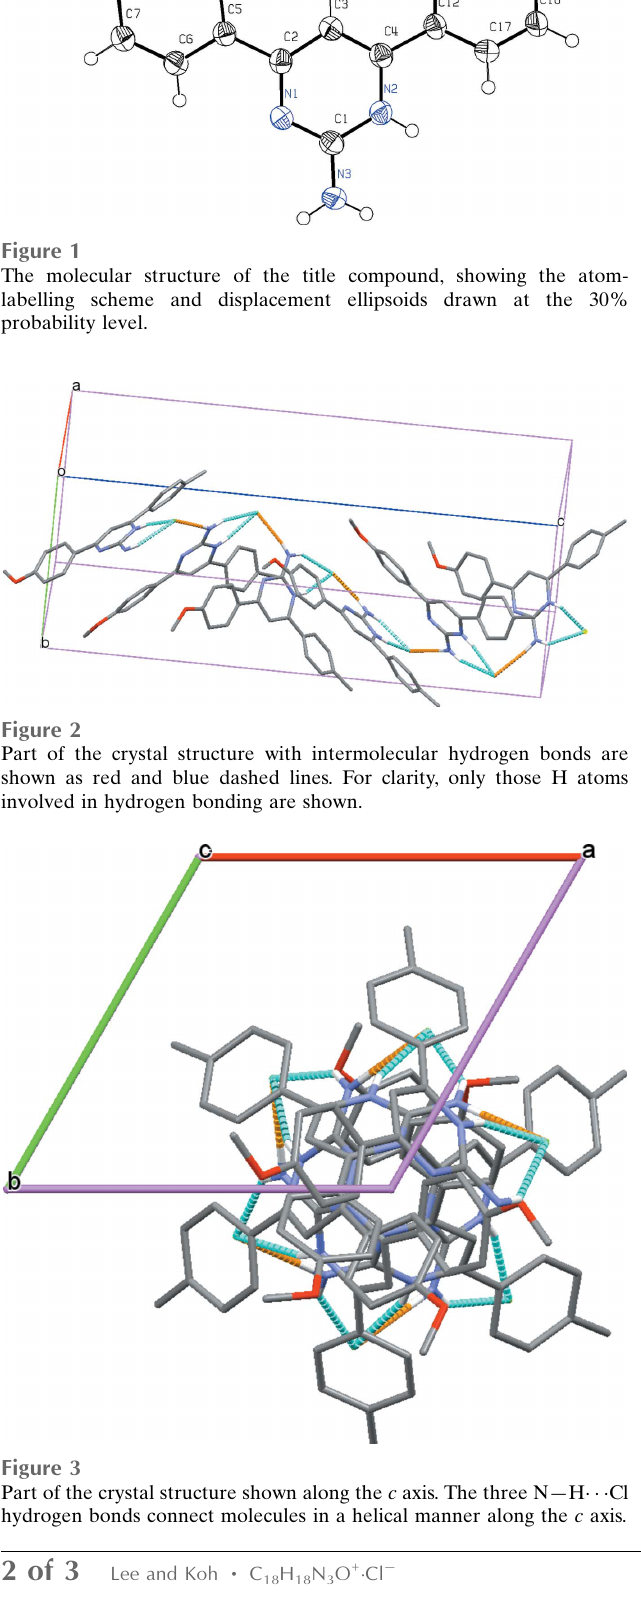
Figure 4 Synthetic scheme for the preparation of the title compound.